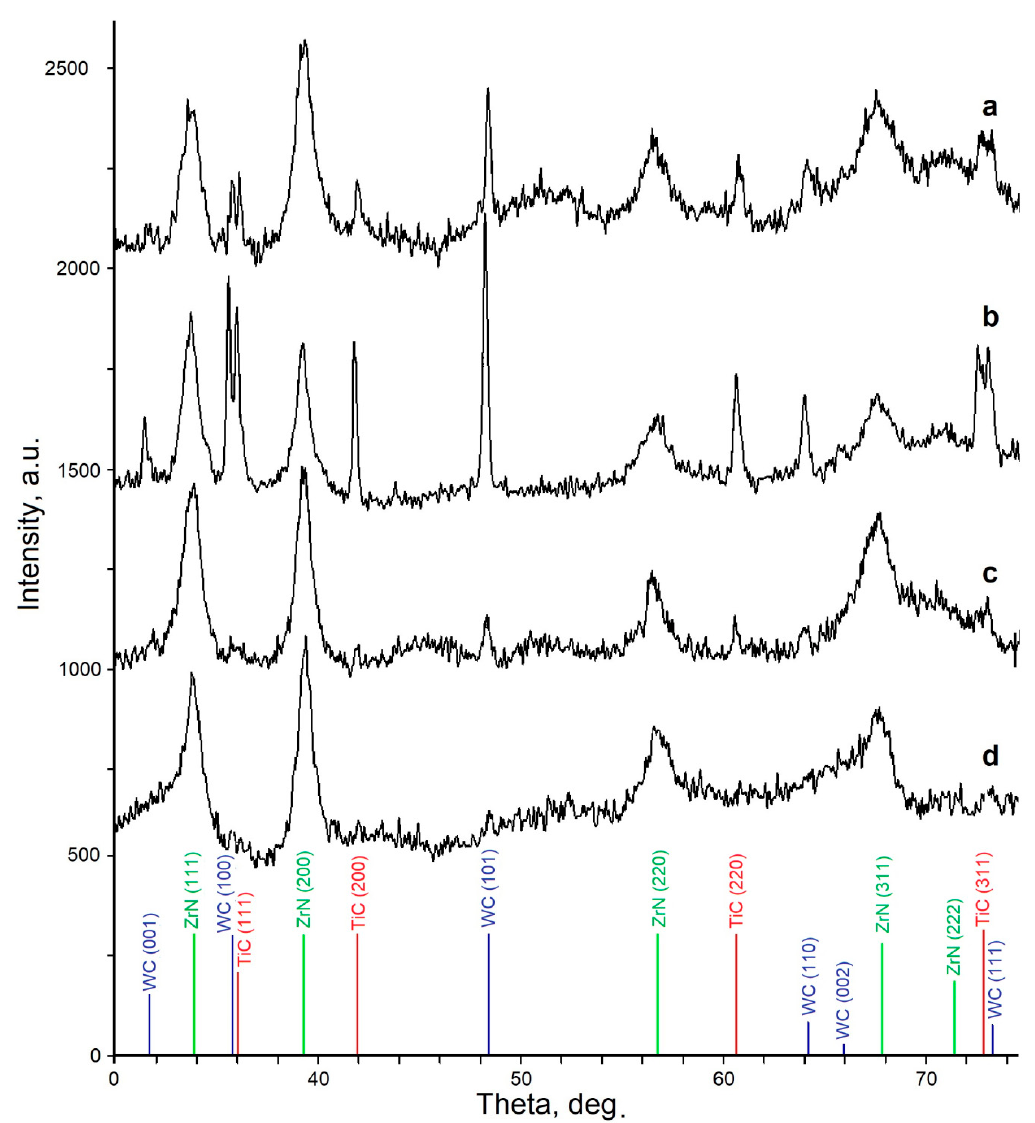
Figure 2. Diffraction patterns of the coatings: Sample 1 (a), Sample 2 (b), Sample 3 (c), and Sample 4 (d).